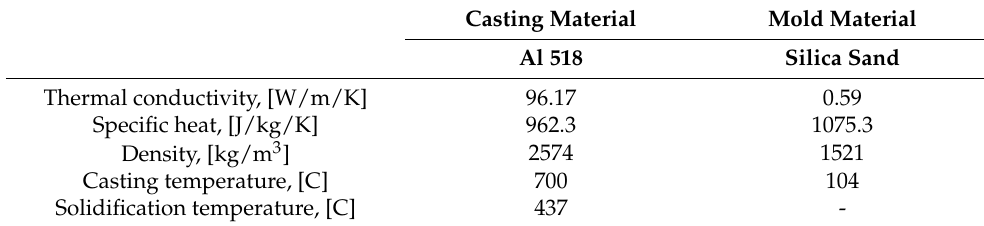
Table 4. Casting and mold material characteristics used in SolidCast.